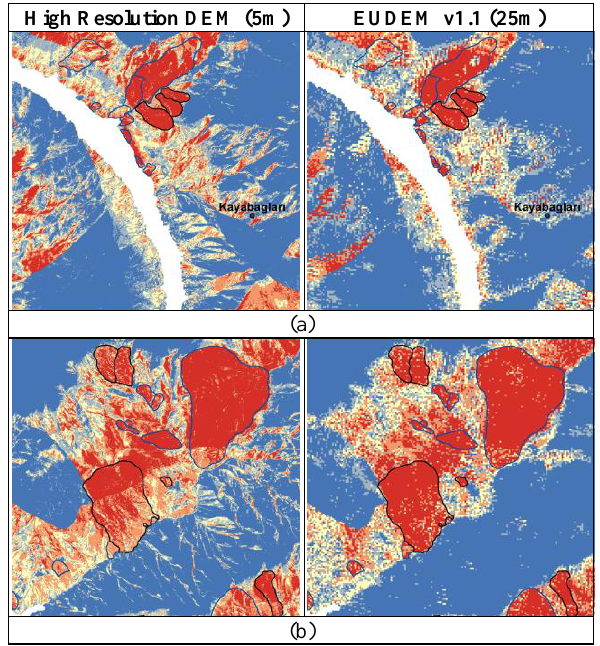
Figure 5 . LS results for both datasets using the RF method